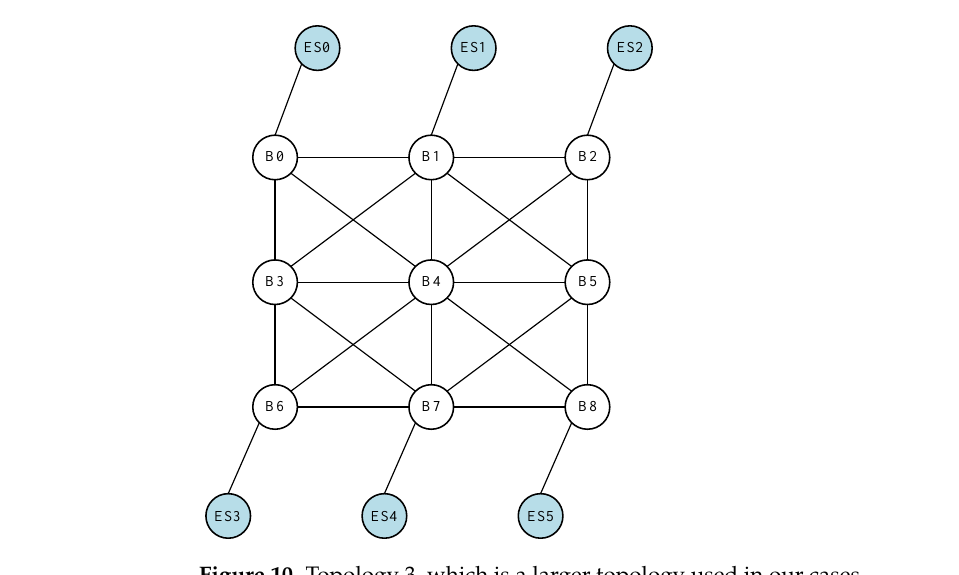
Figure 9. Topology 2, which is a partial mesh topology used in our cases.